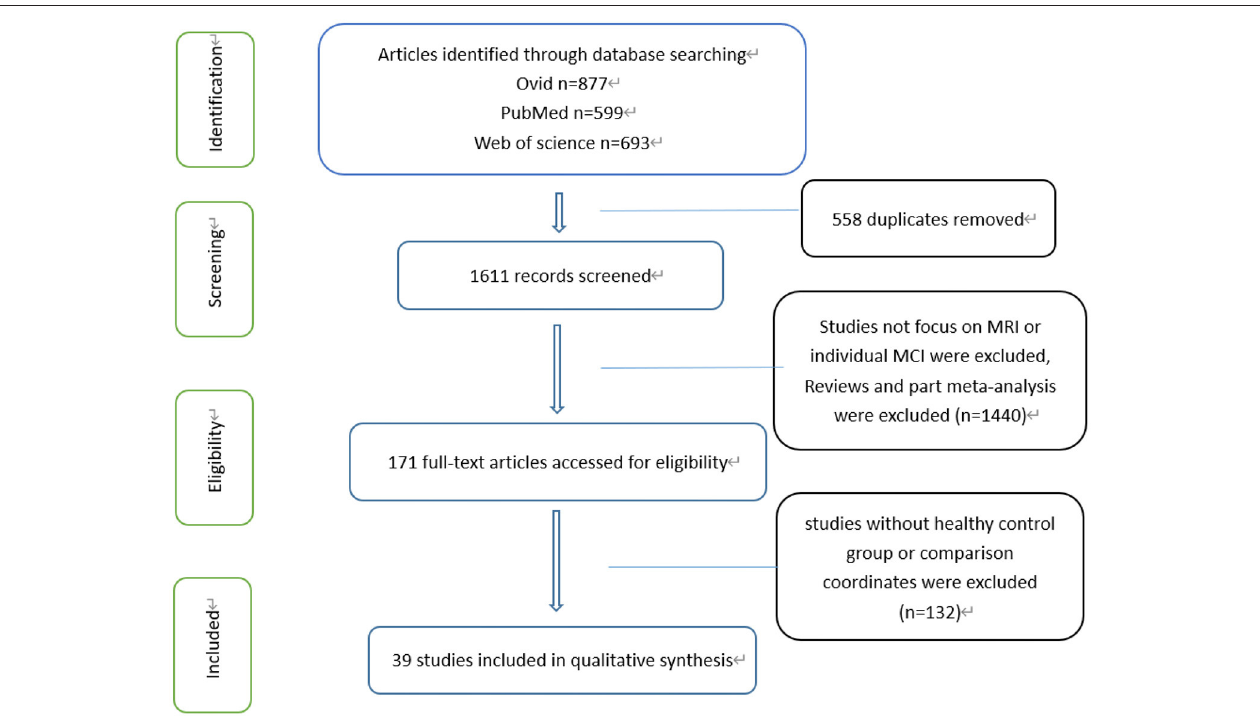
FIGURE 1 | Flow of information through different phases of a systematical